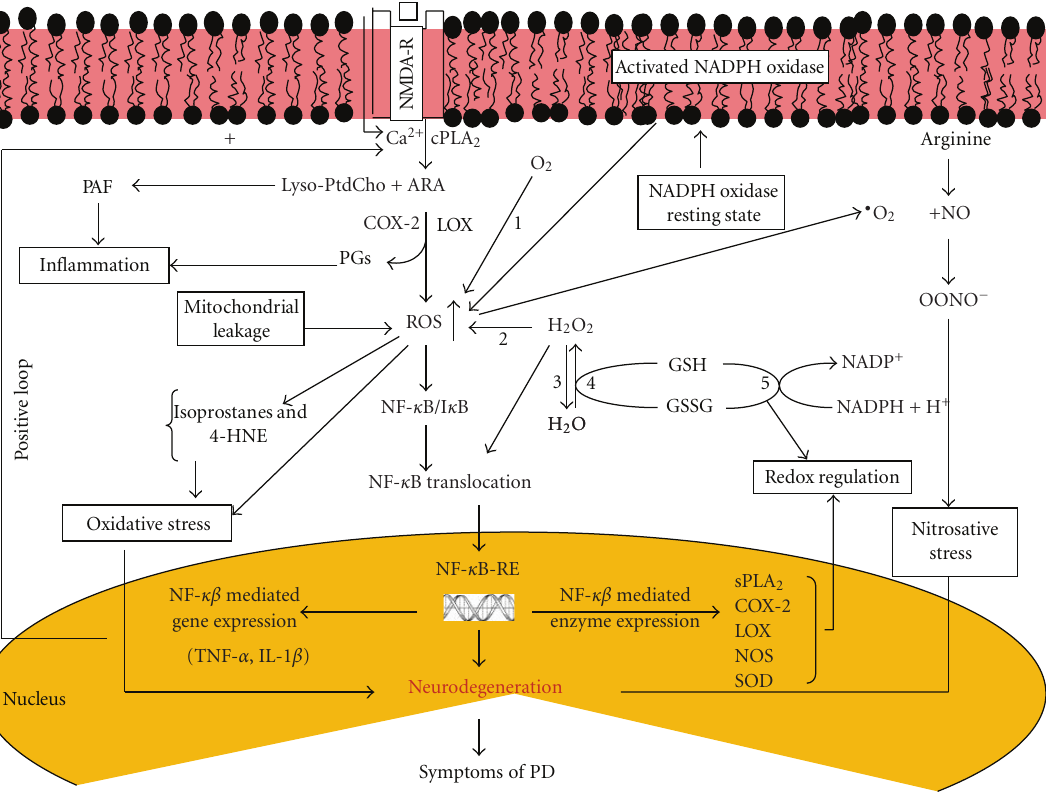
Figure 2: Generation of ROS, activation of NF- κ B, redox status, and gene expression in Parkinson’s disease. (1) NADPH oxidase; (2) superoxide dismutase; (3) catalase; (4) glutathione peroxidase; (5) glutathione reductase; cytosolic phospholipase A 2 (cPLA 2 ); secretory phospholipase A 2 (sPLA 2 ); cyclooxygenase-2 (COX), lipoxygenase (LOX); SOD; nitric oxide synthase (NOS); cytokines, TNF- α and IL-1 β ; reduced glutathione (GSH); oxidized glutathione (GSSG) and hydrogen peroxide (H 2 O 2 ). Increase in oxidative stress-mediated expression of NF- κ B induces transcription of sPLA 2 . COX-2, NOS, and SOD in the nucleus as well as proinflammatory cytokines (TNF- α and IL-1 β ) that further upregulate activities of cPLA 2 , sPLA 2 , NOS through a positive loop mechanism in cytoplasm and neural